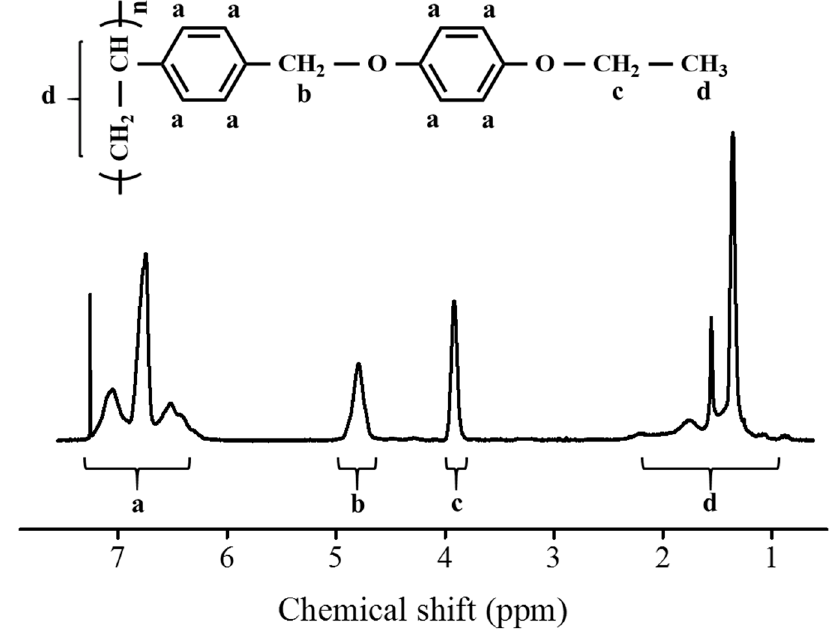
Polymers 2021 , 13 , x FOR PEER REVIEW 7 of 13 1 H nuclear magnetic resonance (NMR) spectrum of PEOP. Figure 2. 1 H nuclear magnetic resonance (NMR) spectrum of PEOP. Figure 2.